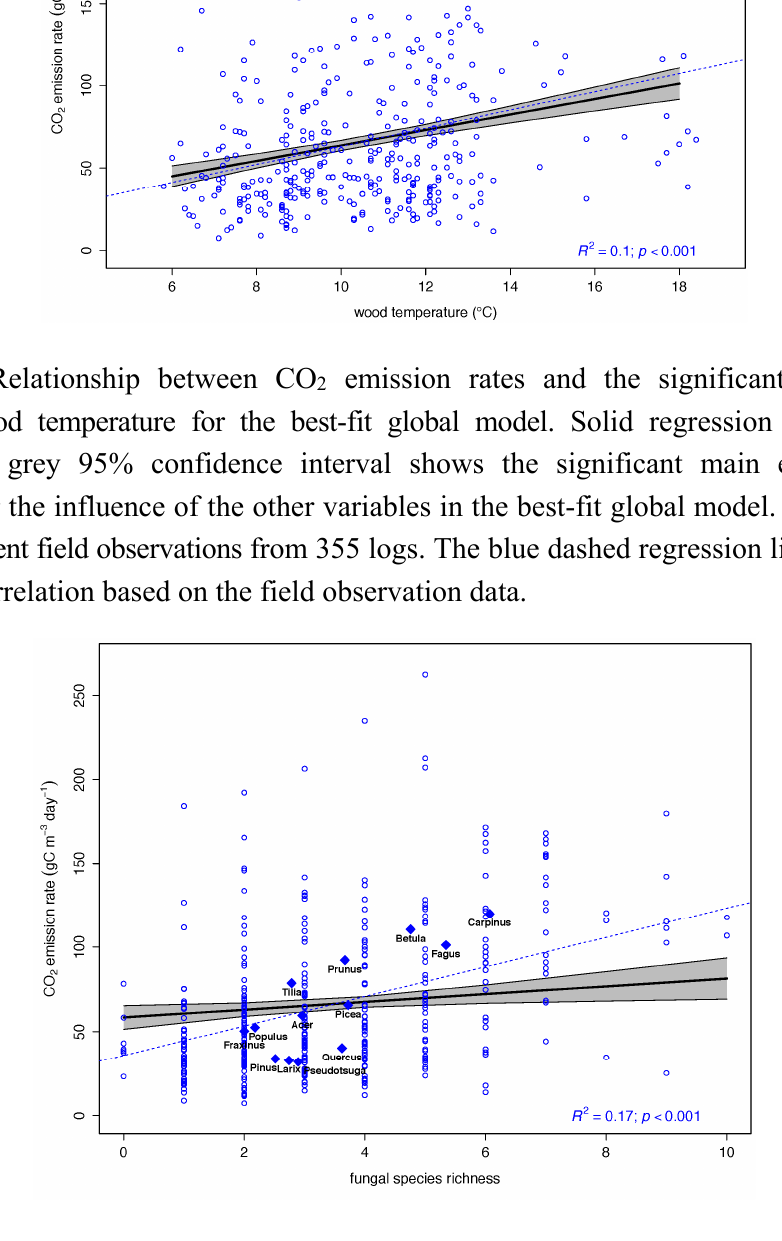
Figure 4. Relationship between CO 2 emission rates and the significant explanatory variable fungal species richness for the best-fit global model. Solid regression line and the surrounding grey 95% confidence interval shows the significant main effect and is corrected for the influence of the other variables in the best-fit global model. The blue data points represent field observations from 355 logs. The blue dashed regression line represents the linear correlation based on the field observation data. Blue diamonds represent mean field observation values by tree